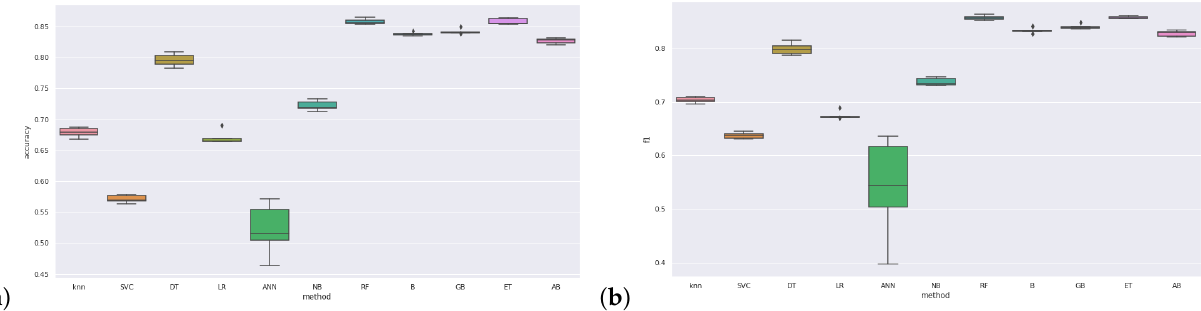
Figure 7. Performance results after using smote to balance the data ( a ) accuracy score and ( b ) f1-score.